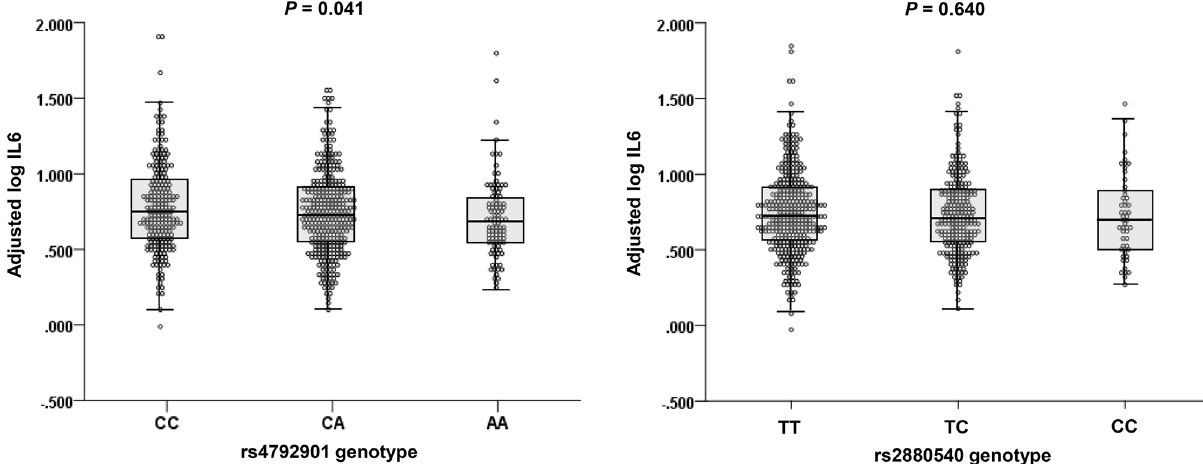
Figure 5. Scatter and box plots of adjusted serum log IL6 levels by rs4792901 and rs2880540. genotypes. The levels of IL6 were adjusted for gender, age, smoking status, and the other SNP genotype. The horizontal line in each box represents the median. The top and bottom box lines show the 25th and 75th percentiles, respectively. The whiskers show the maximum and minimum values, with the exceptions of outliers and